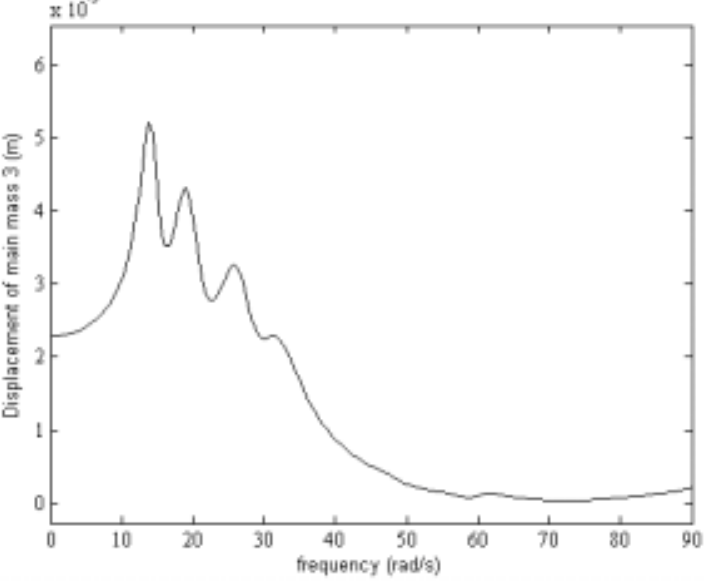
Fig. 15. Displacement of main mass 3 (with optimal